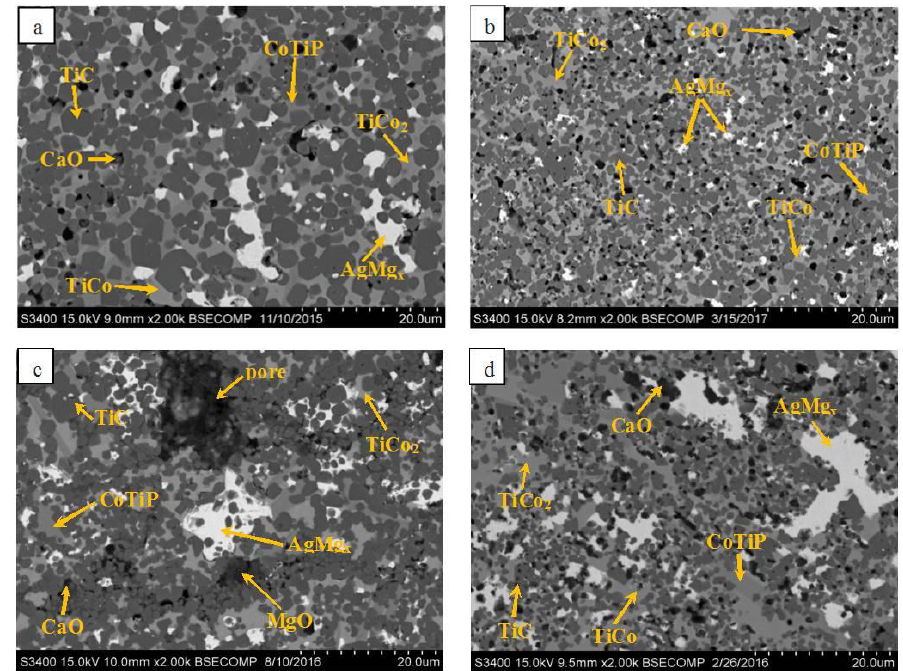
Figure 6. The microstructures of the synthesis compact products from the Ti – C – Co – Ca 3 (PO 4 ) 2 – Ag – Mg mixtures composed of: X = 13% (BRM) ( a ); X = 13% (MA for 5 min) ( b ); X = 13% (MA for 9 min) ( c ); X = 24% (MA for 5 min) ( d ).